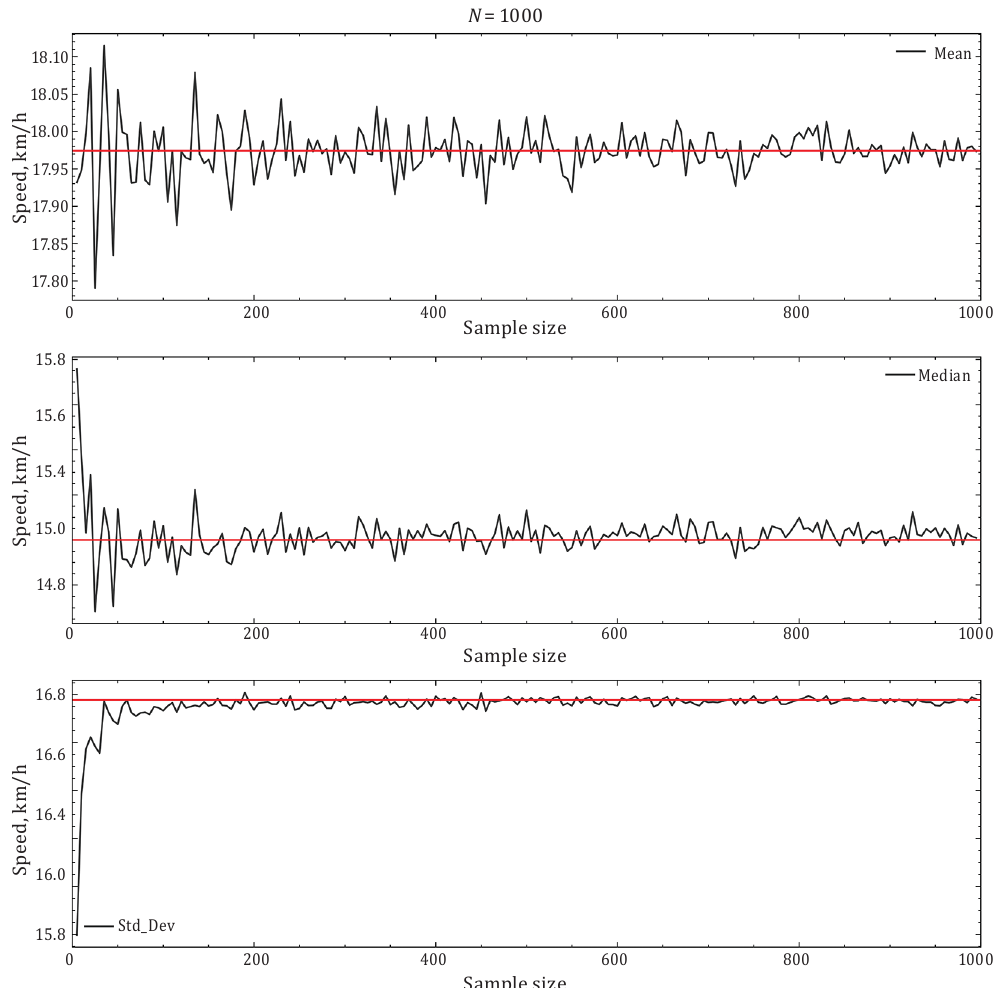
Figure 5. Change of the mean of the subsample relative to the sample size for speed,